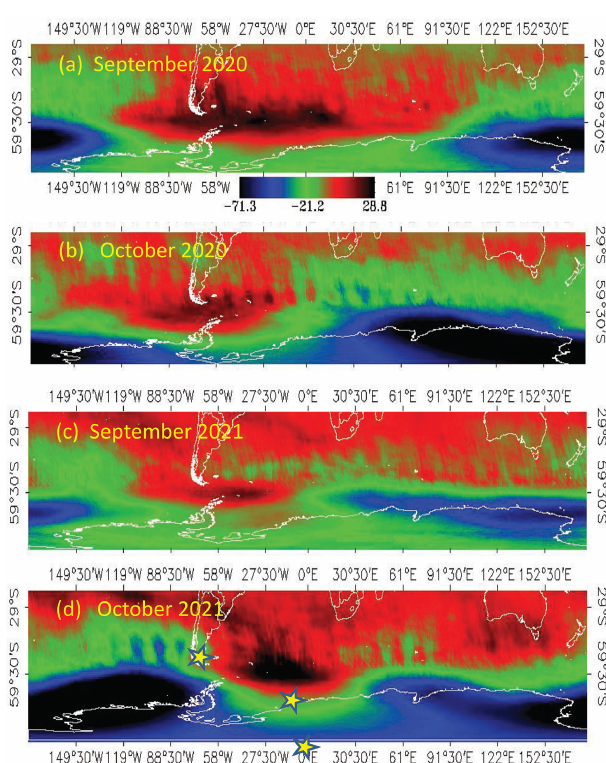
Figure 5. (a, c) September and (b, d) October 2020 and 2021 col- umn ozone deviations (monthly means in Dobson units) from the re- spective September and October 2010–2019 column ozone means. Observations of the Ozone Monitoring Instrument (OMI) aboard the NASA Aura spacecraft are used (OMI, 2022). Both years are similar regarding the additional ozone loss pattern over Antarctica (green, blue and black colors). In (d) , Punta Arenas (53.2 ◦ S), the Neumayer (70.6 ◦ N) and the South Pole stations are indicated by yellow stars.